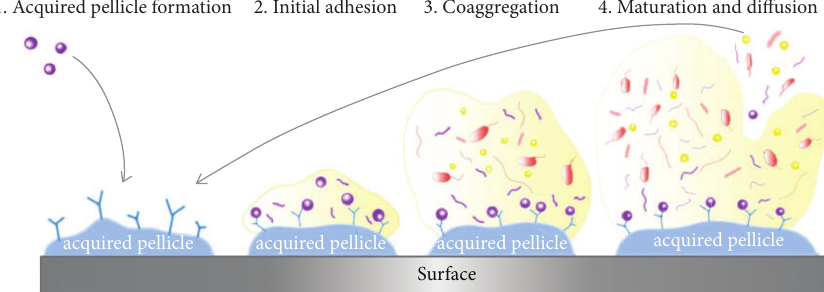
Figure 1: The formation stages of biofilm